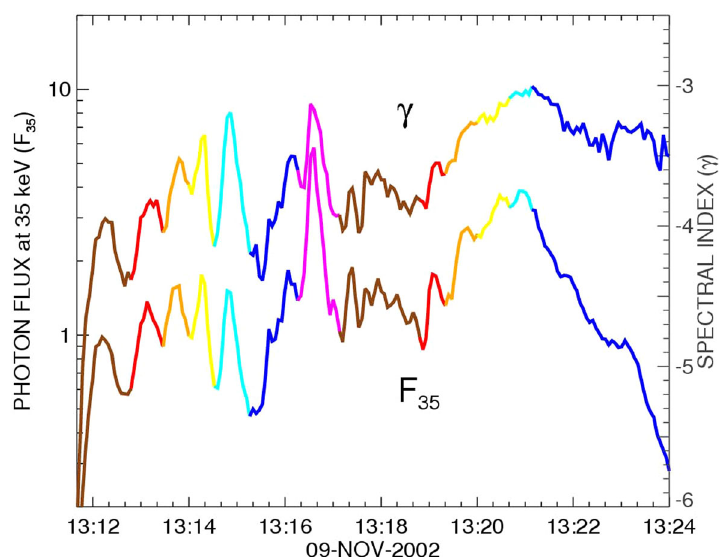
Fig. 29 Flux density at 35 keV and power-law index as determined from RHESSI observations of the non-thermal component of flare hard X-ray emission in SOL2002-11-09. Colors mark individual subpeaks. The close correlation demonstrates soft-hard-soft behavior in the smallest details. Image courtesy of Paolo Grigis, for details see Grigis and Benz (2004)